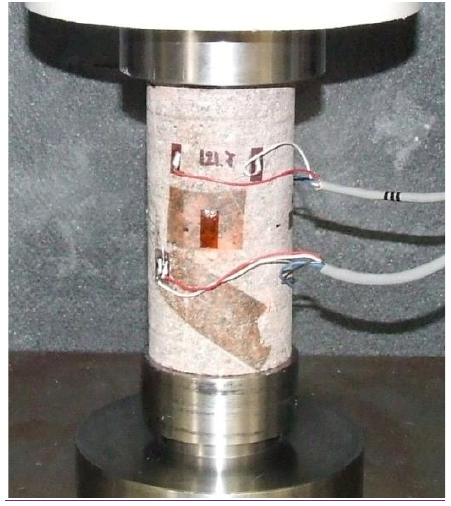
Fig. 4.: A prepared sample in the beginning of the UCS test.